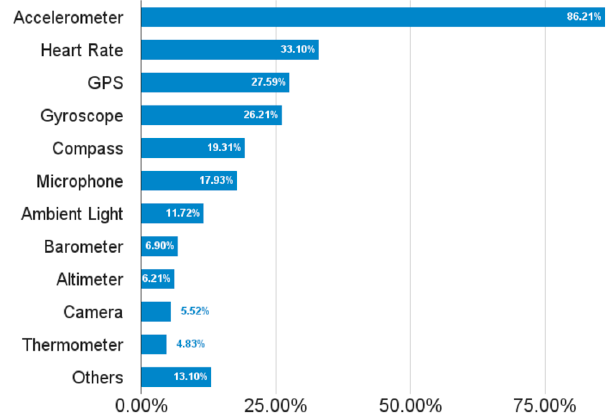
Figure 3. Sensors available in wearables.